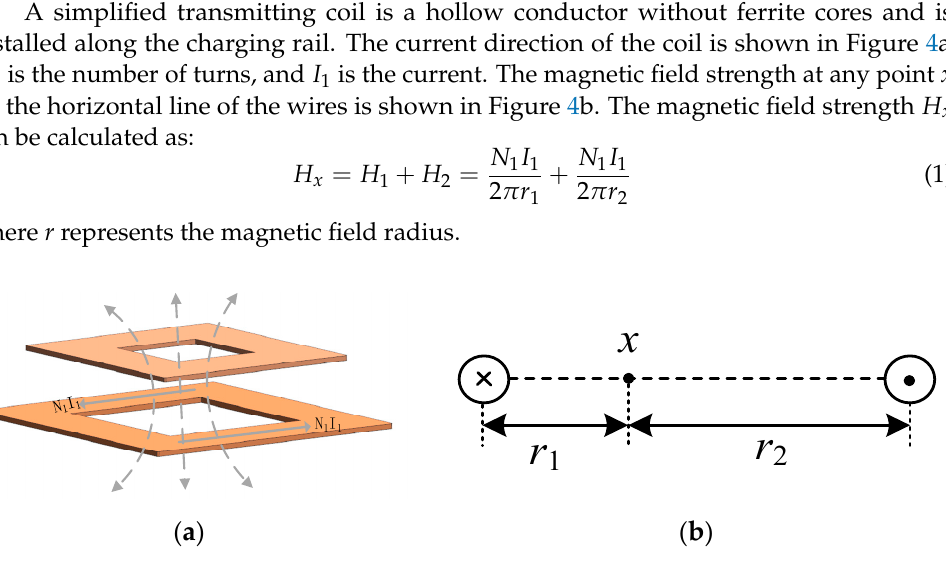
Figure 4. ( a ) Schematic diagram of current direction; ( b ). Magnetic field strength at point x . According to the principle of magnetic field strength, the magnetic flux density at the point x can be obtained: